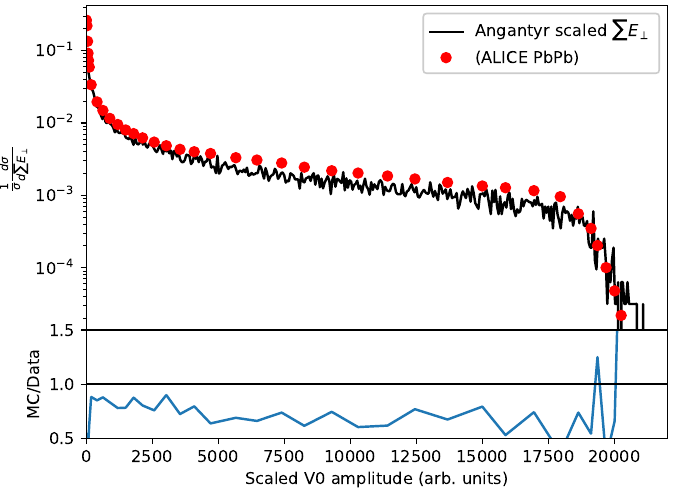
Figure 15 . Scaled E ? of charged particles at Angantyr, compared with the ALICE V0 amplitude, data taken from ref. P